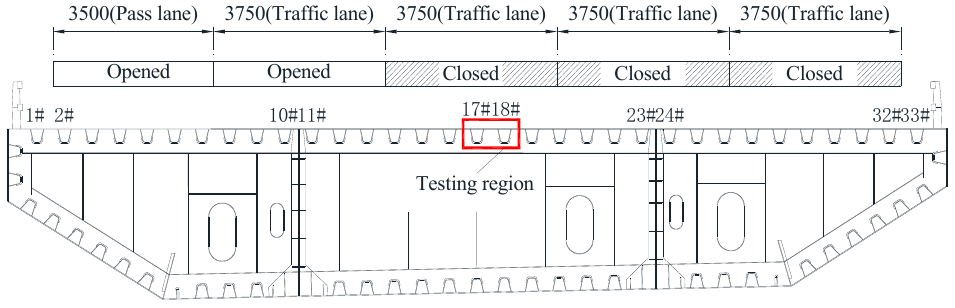
Figure 2. Cross-section of the steel box girder of a suspension bridge.